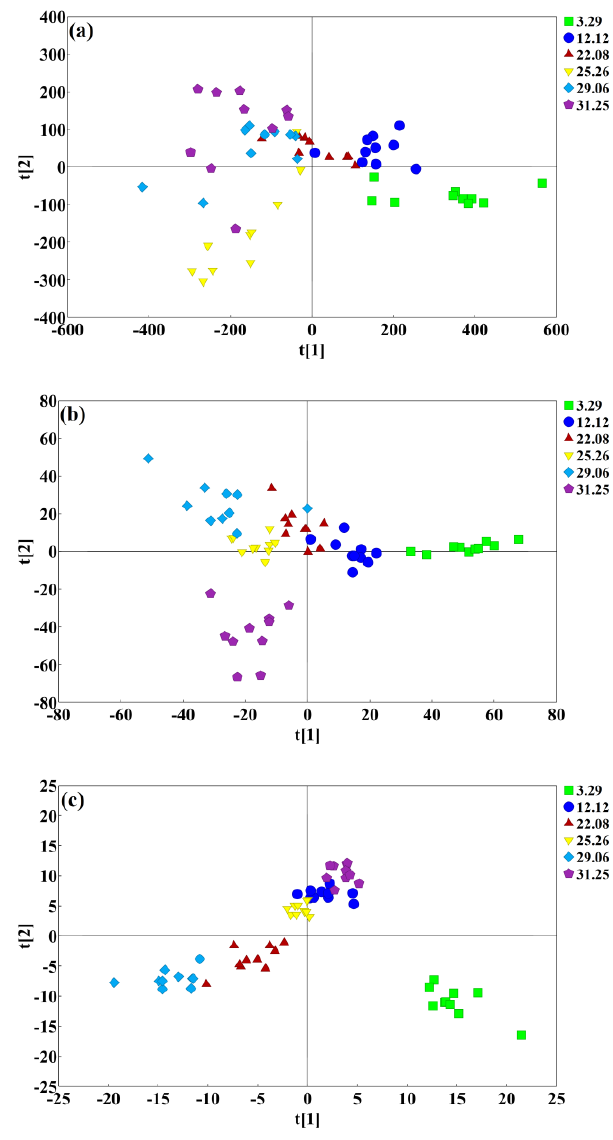
Figure 4. Orthogonal partial least squares-discriminant analysis (OPLS-DA) score plots of the smoothed and baseline corrected spectra ( a ), first derivative treated spectra ( b ), and second derivative treated spectra ( c ).